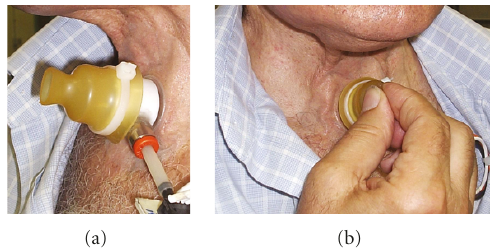
Figure 1: Device for tracheostoma pressure measurement.